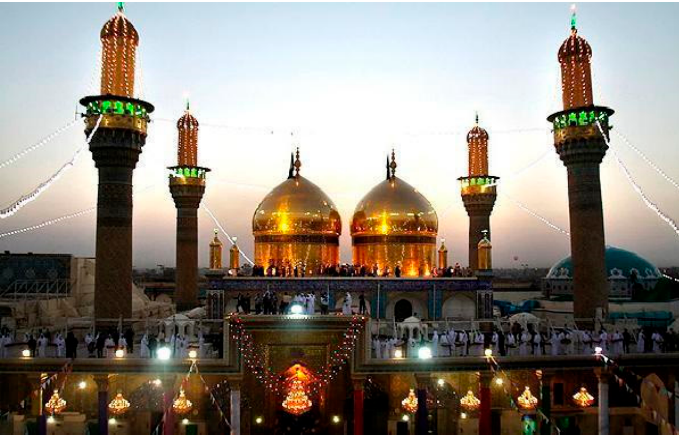
Figure 7. Shrine of Imam Musa AlKadhim in Baghdad, Iraq with its four minaret structures.